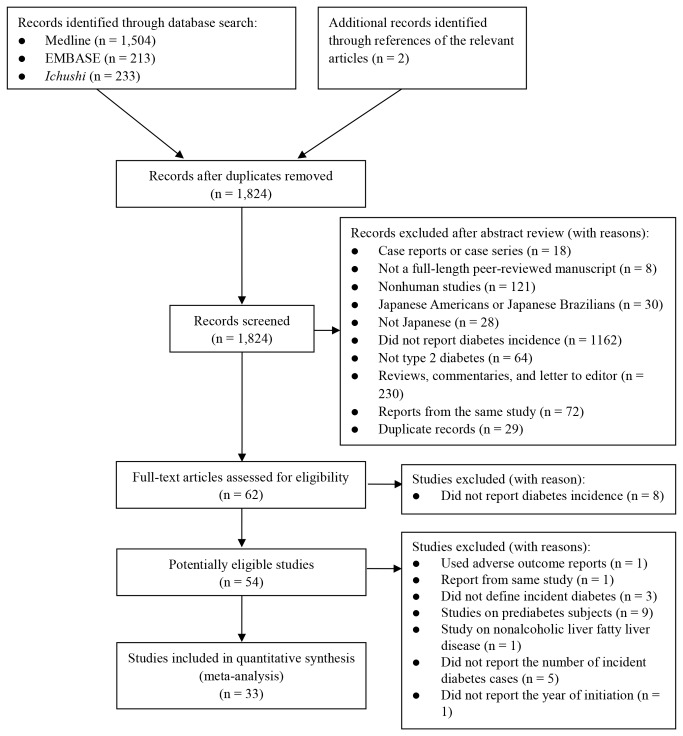
Literature search.